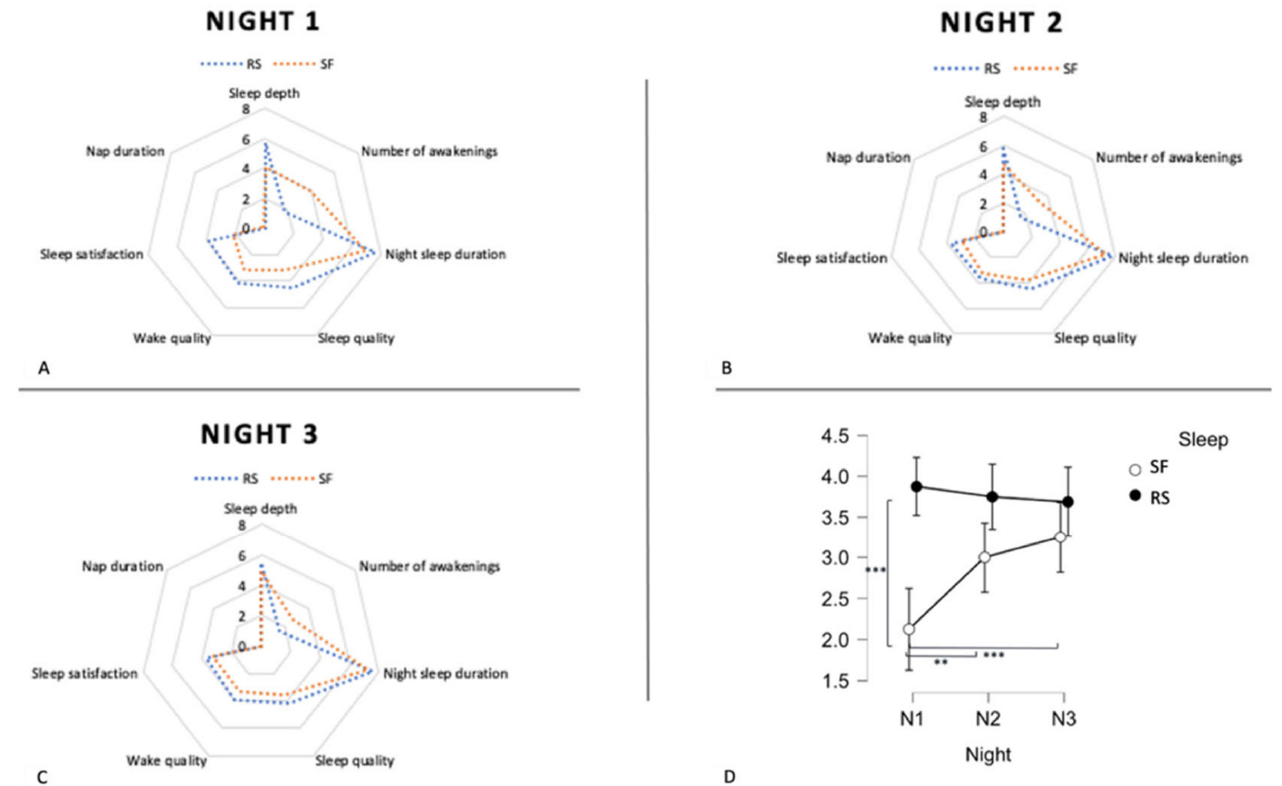
Figure 3. Subjective sleep variables in RS and SF conditions. ( A – C ) Sleep parameters for each of the three nights in the RS (blue) and SF (red) conditions. ( D ) Sleep satisfaction across nights and sleep conditions. N1 = Night 1, N2 = Night 2, N3 = Night 3. ** p < 0.01, *** p < 0.001.